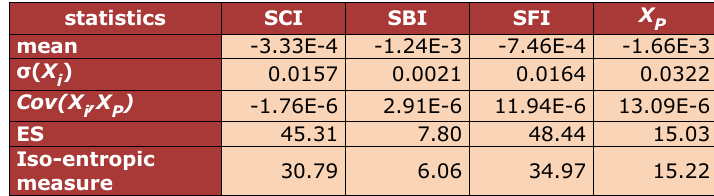
Table 1. The risk amount of portfolios based on different